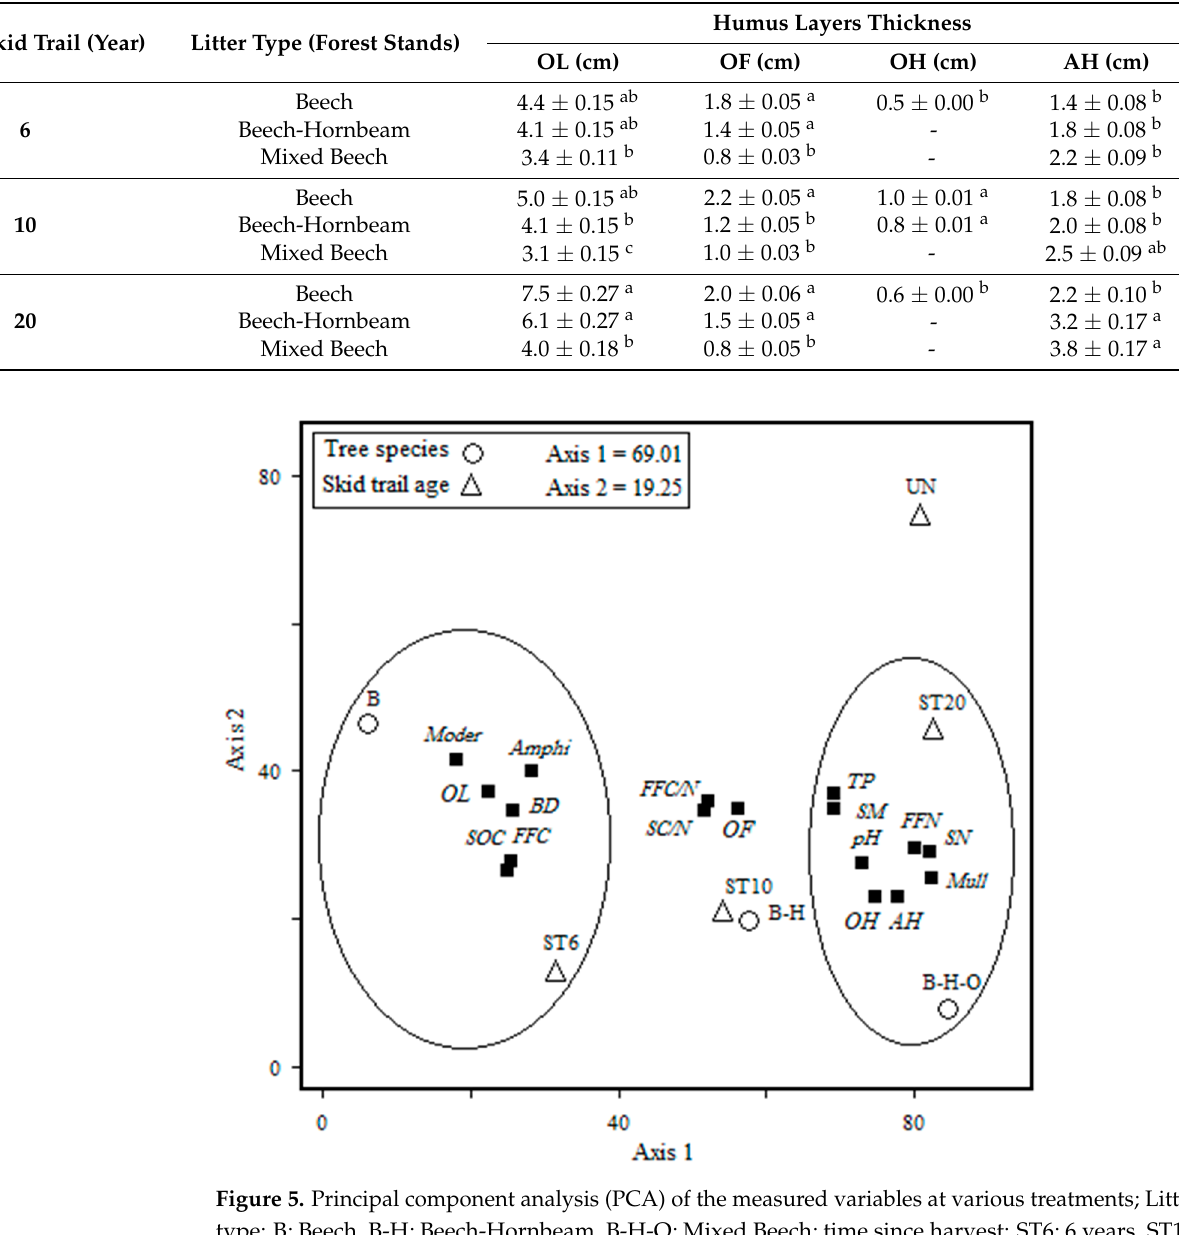
Table 3. Thickness of organic humus (OL, OF and OH) and organic-mineral (AH) layers in relation to the interaction of different litter types and the age of skid trail. Different letters indicate a significant difference among different altitudes, done by Duncan’s test ( p < 0.05).